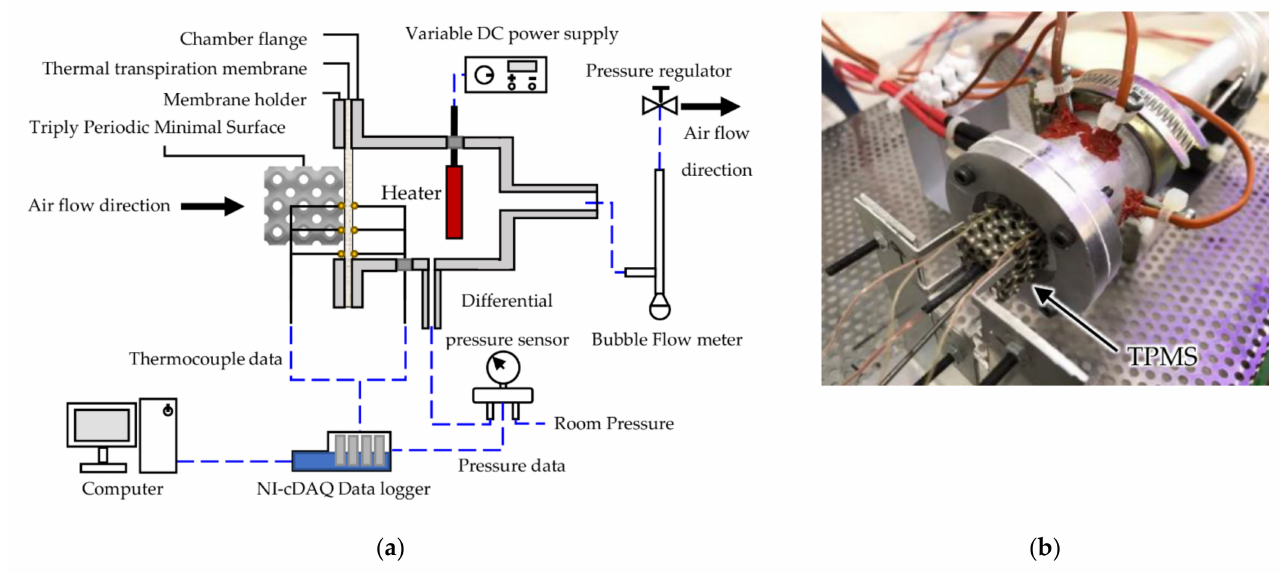
Figure 3. Experimental setup for membrane performance test: ( a ) schematic diagram; ( b ) as-built setup.